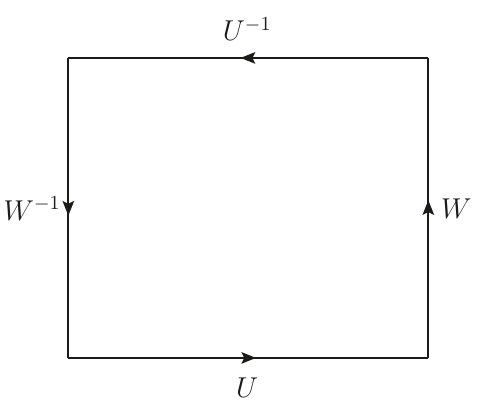
Figure 15 . The partition function for the 2D U( N ) gauge theory on a torus is obtained from the K-functional for the rectangle by integrating out the group elements U and W corresponding to the identi(cid:12)ed